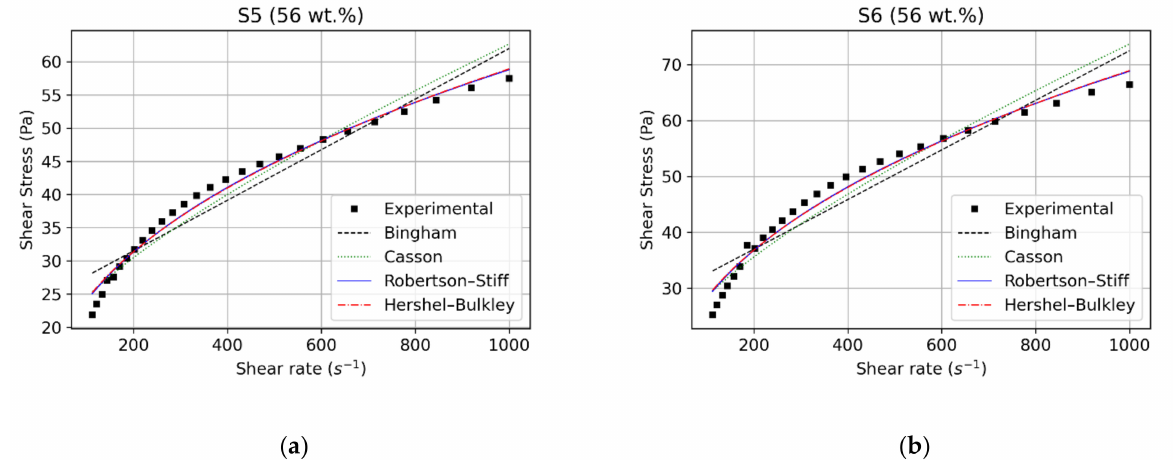
Figure 6. Comparison of rheological model fits for ( a ) S5 and ( b ) S6.